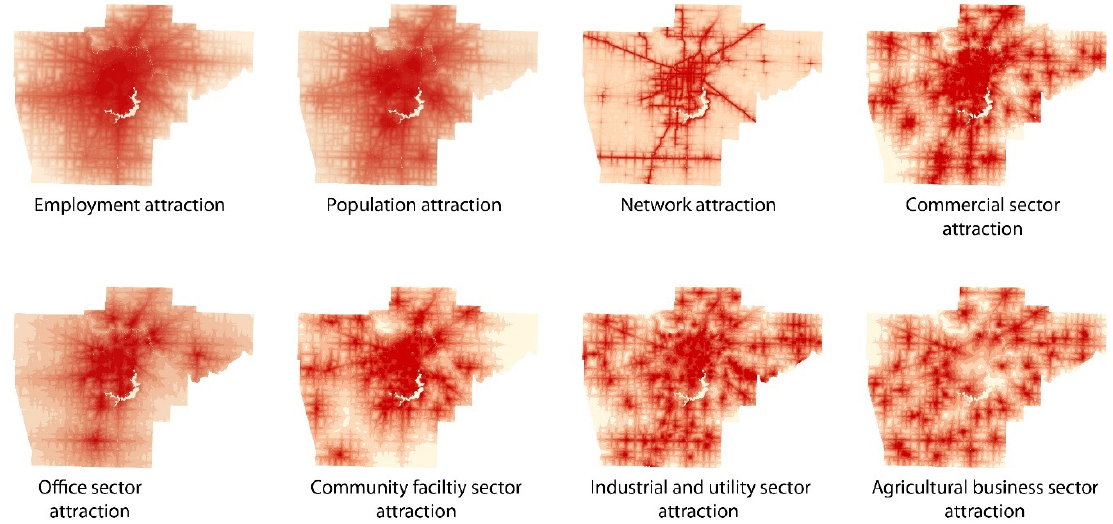
Figure 7. Attraction maps displaying the accessibility to attractors (e.g., population centers) based on shortest travel time. The deeper red represents higher attraction from the attractors.